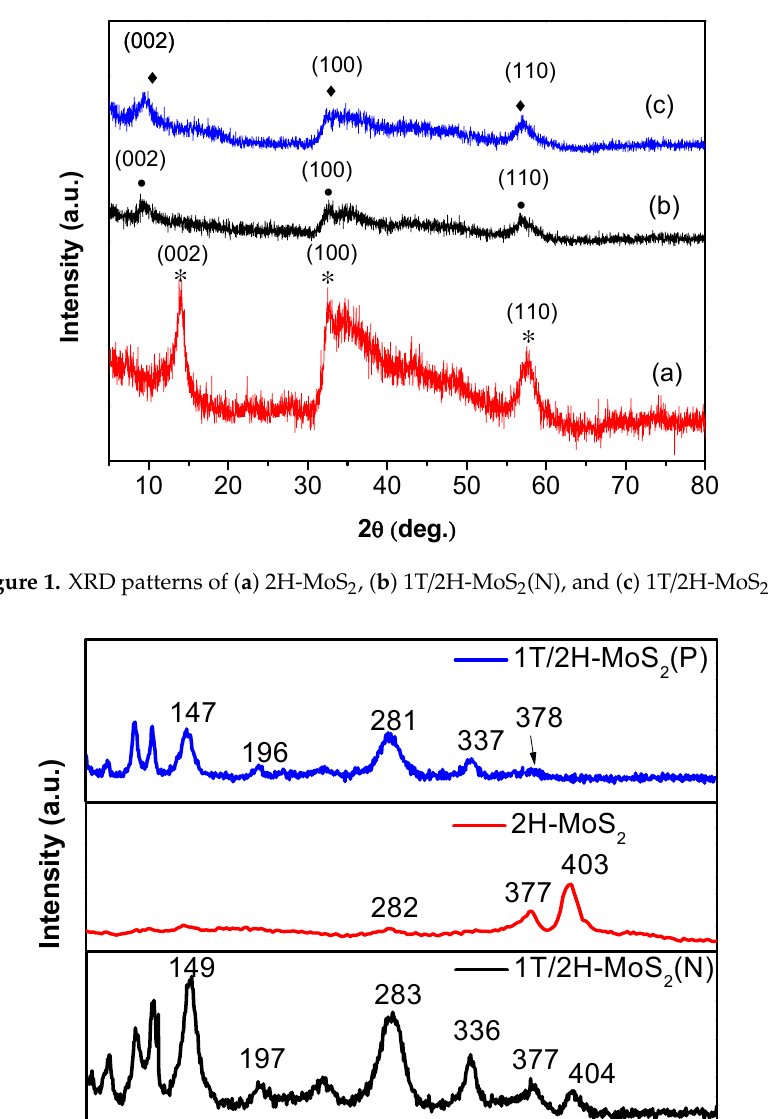
Figure 2. Raman spectra of 1T/2H-MoS 2 (N), 2H-MoS 2 , and 1T/2H-MoS 2 (P).